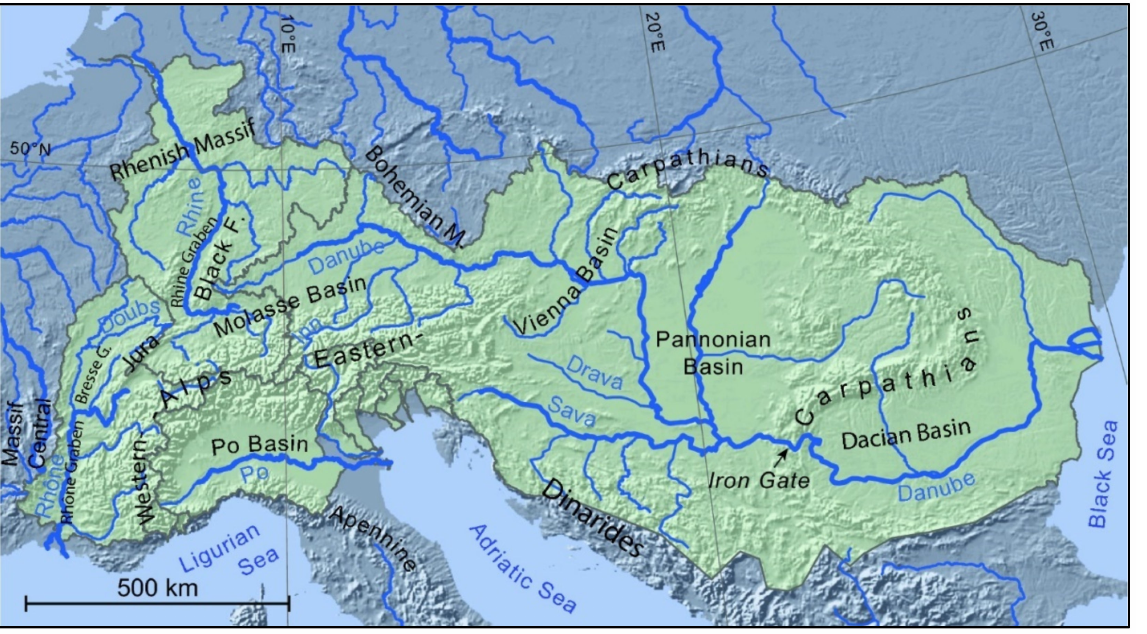
Figure 5. The hydrographic catchment areas of the Rhine, Rh ô ne, Po and Danube rivers draining the Alps